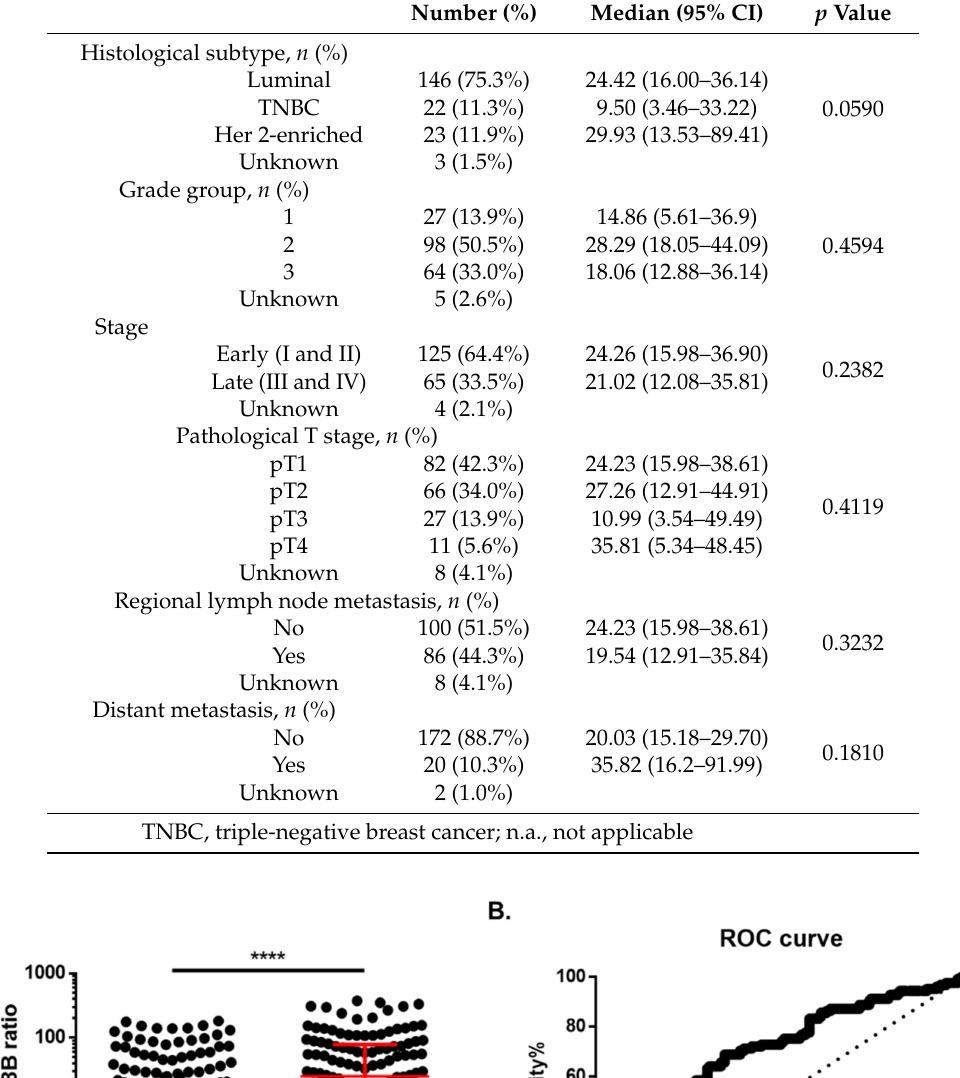
Table 4. Association between circulating miR-99a levels and clinicopathological features of breast cancer patients (cohorts #2 and #3).